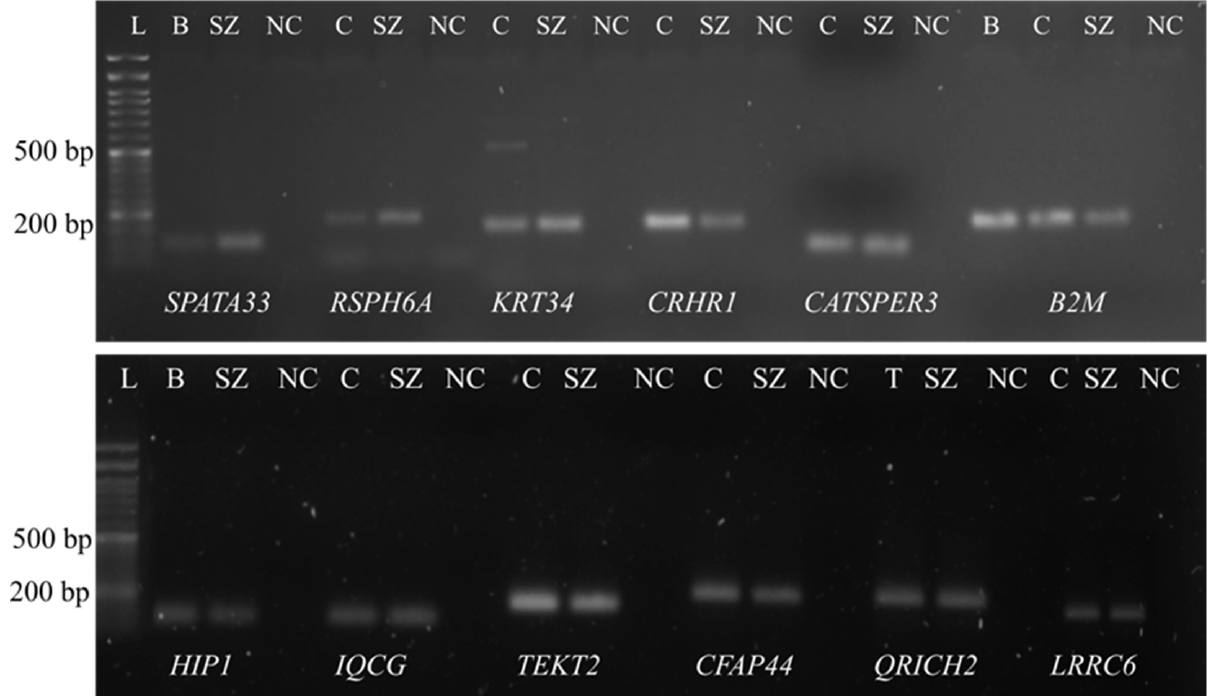
Figure 1. The presence of SPATA33 , RSPH6A , KRT34 , CRHR1 , CATSPER3 ( in the upper gel ), HIP1 , IQCG , LRCC6 , QRICH2 , TEKT2 and CFAP44 ( in the lower gel ) transcripts in human ejaculated spermatozoa identified by PCR and running on a 1.5% agarose gel. B2M was used as control for the different tissues. L, DNA Ladder; B, blood; C, ciliated cells; T, testis; SZ, purified spermatozoa; NC, negative control.